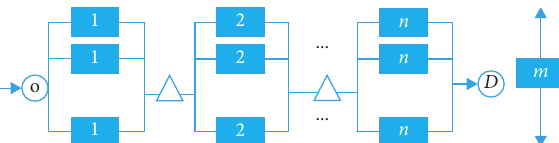
Figure 3: Schematic diagram of the series-parallel system.